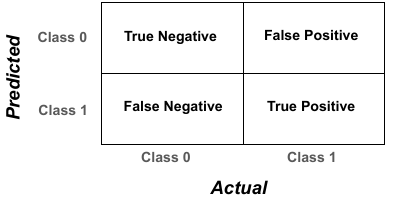
Figure 3. Confusion matrix for a binary classification problem. The matrix contains four elements that, together, evaluate the system’s predictions versus the real